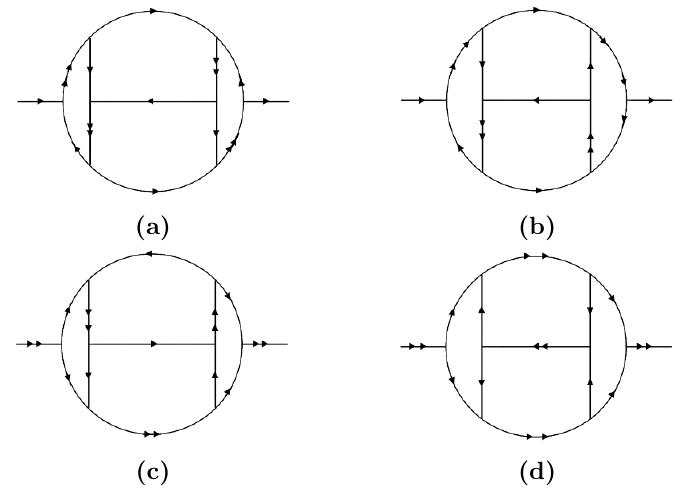
Figure 10. Allowed assignments of arrows to the lines of diagram (c) in (cid:12)gure 9.